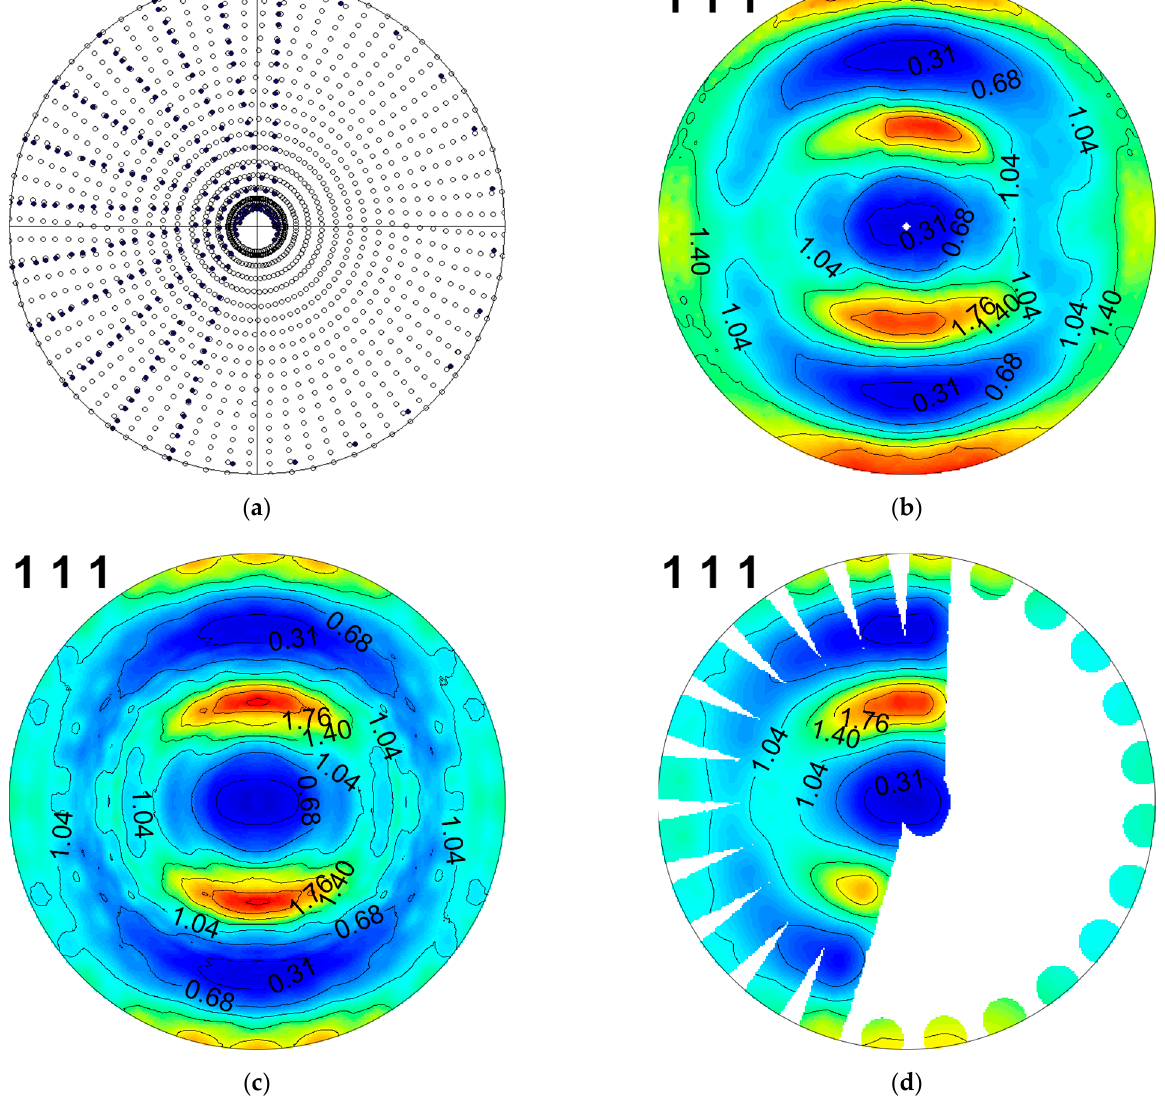
Figure 6. Experimental pole figures of γ -111 in textured martensite–austenite multilayered steel. ( a ): Open markers show orientation sampling coverage at large and small wavenumbers, k 1 = 4.08 Å − 1 and k 2 = 2.61 Å − 1 , respectively. ( b , d ): Experimental sampled values at refined peak position. ( c ): Recalculated pole figure of refined texture on dual wavenumber complete